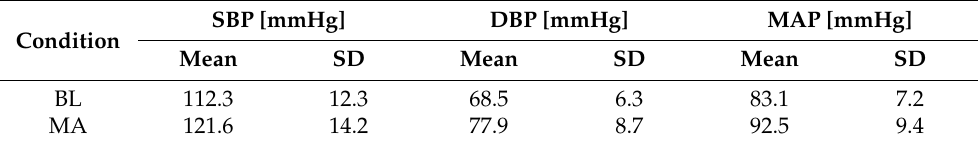
Table 1. Participants’ BPs measured with a cuff sphygmomanometer in each measurement condi- tion.